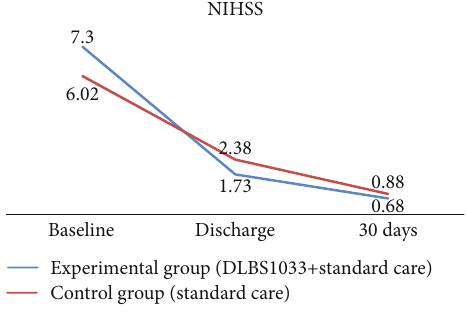
Figure 2: Change from baseline in the mean average National Institutes of Health Stroke Scale (NIHSS) score during the treatment period and follow-up period.